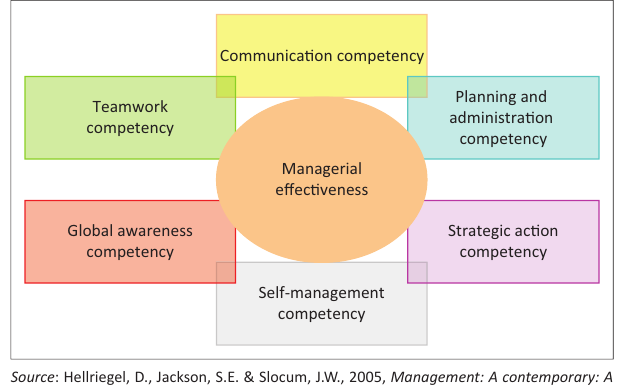
FIGURE 2: Managerial competencies model graphic